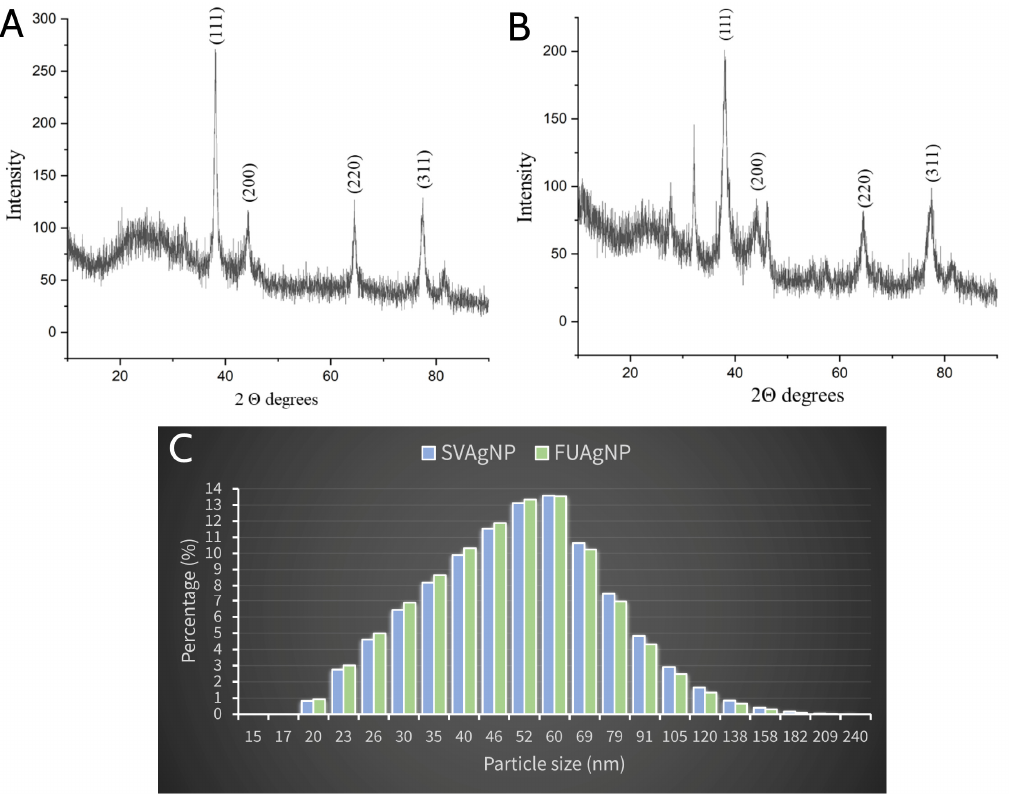
Figure 6 . XRPD pattern of synthesized SVAgNP ( A ) and FUAgNP ( B ); DLS analysis of synthesized SVAgNP and FUAgNP ( C ).